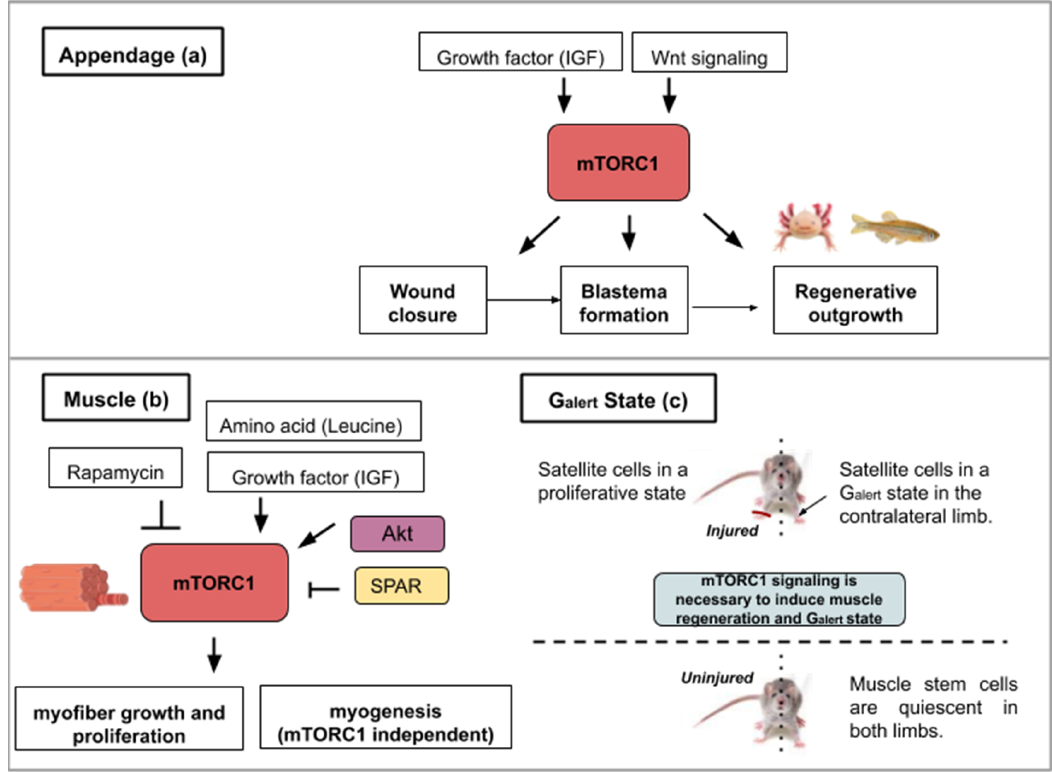
Figure 2. This figure illustrates the ways in which activity from the mTOR signaling pathway contributes to appendage ( a ) or muscle regeneration ( b , c ): ( a ) Concerning appendage regeneration, the Wnt/β-catenin pathway and insulin-like growth factor (IGF-1) activate mTORC1. This activity leads to the wound covering, blastema formation and regenerative outgrowth of the appendage. ( b ) During muscle regeneration, mTORC1 activity is necessary for myofiber growth but not